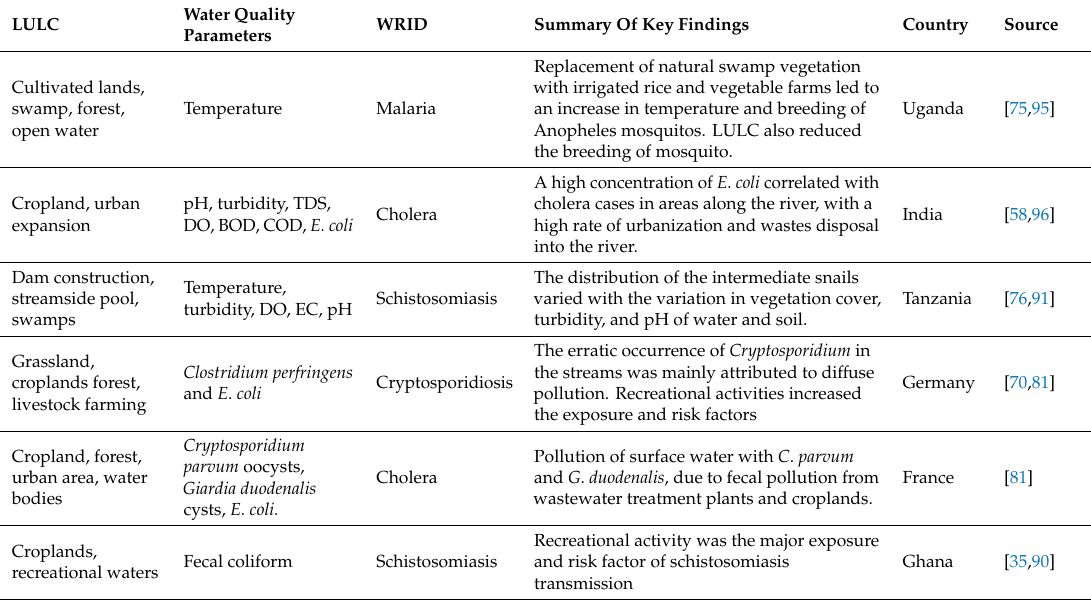
Table 4. Combined influences of land-use and land-cover (LULC) types on water quality and water-related infectious diseases